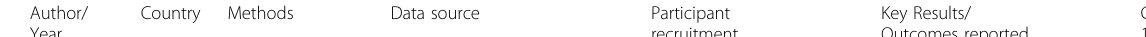
Table 2 Study Characteristics of Included Studies and Thematic Categories (1 CM education provision, 2 The development of educational competencies to develop clinical skills and standards, 3 Application of new educational theory, methods and technology in CM, 3 Future Challenges facing CM education)